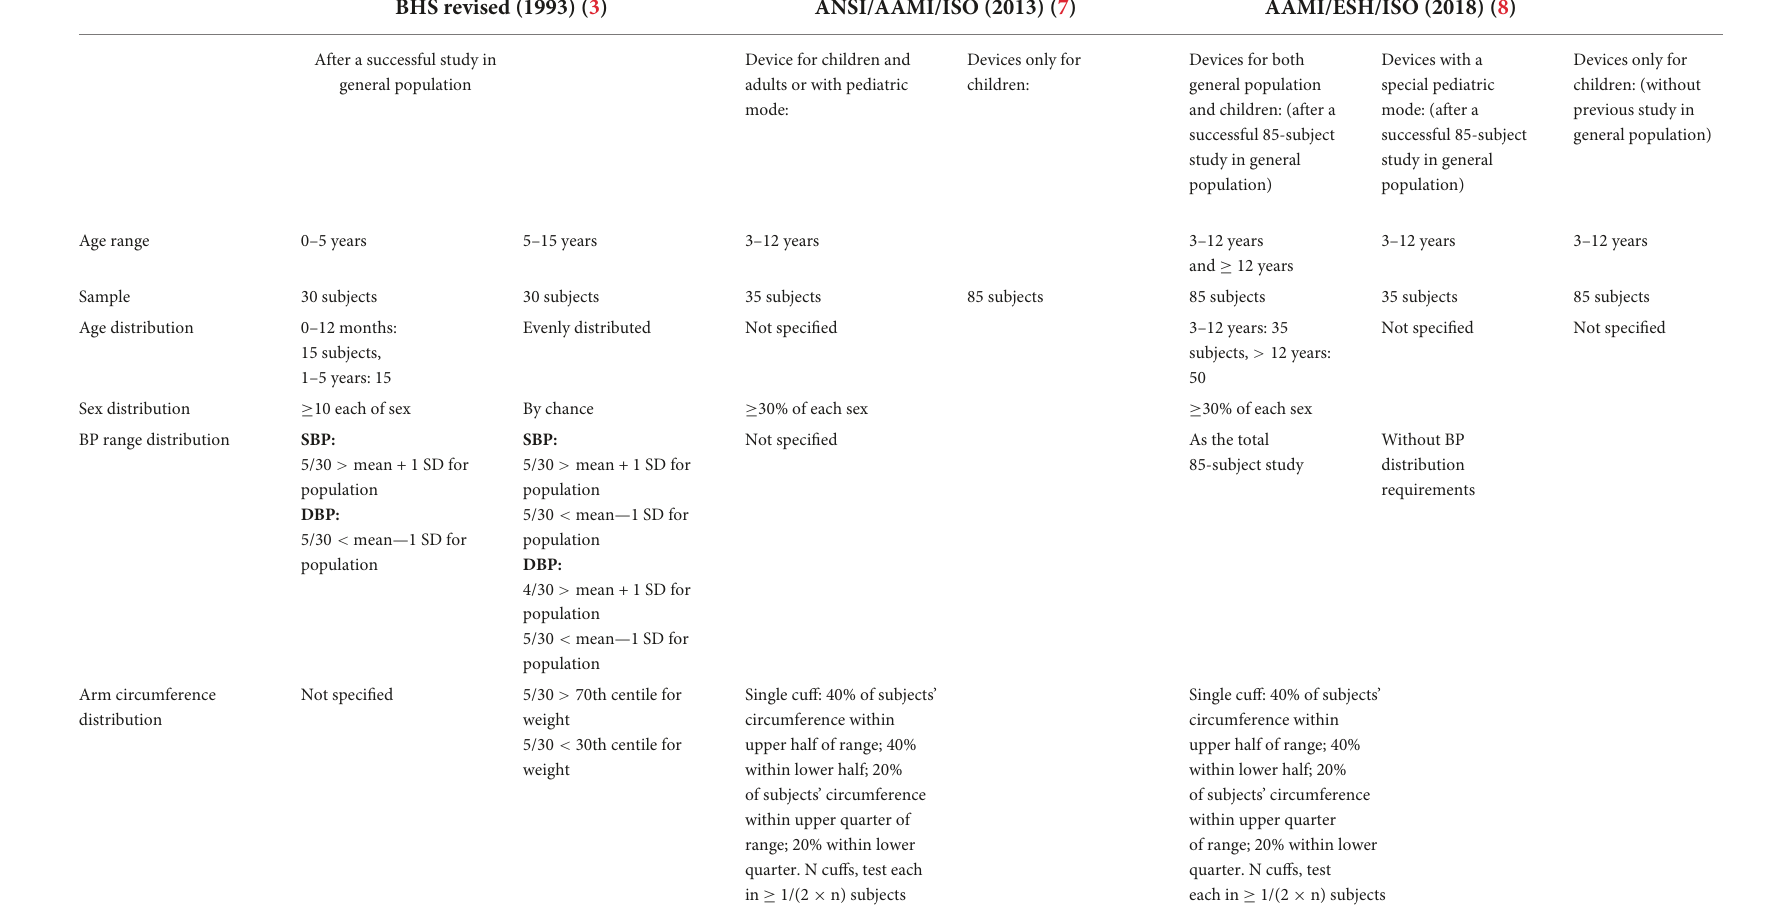
TABLE 2 Comparison of validation protocols for BP measuring devices in